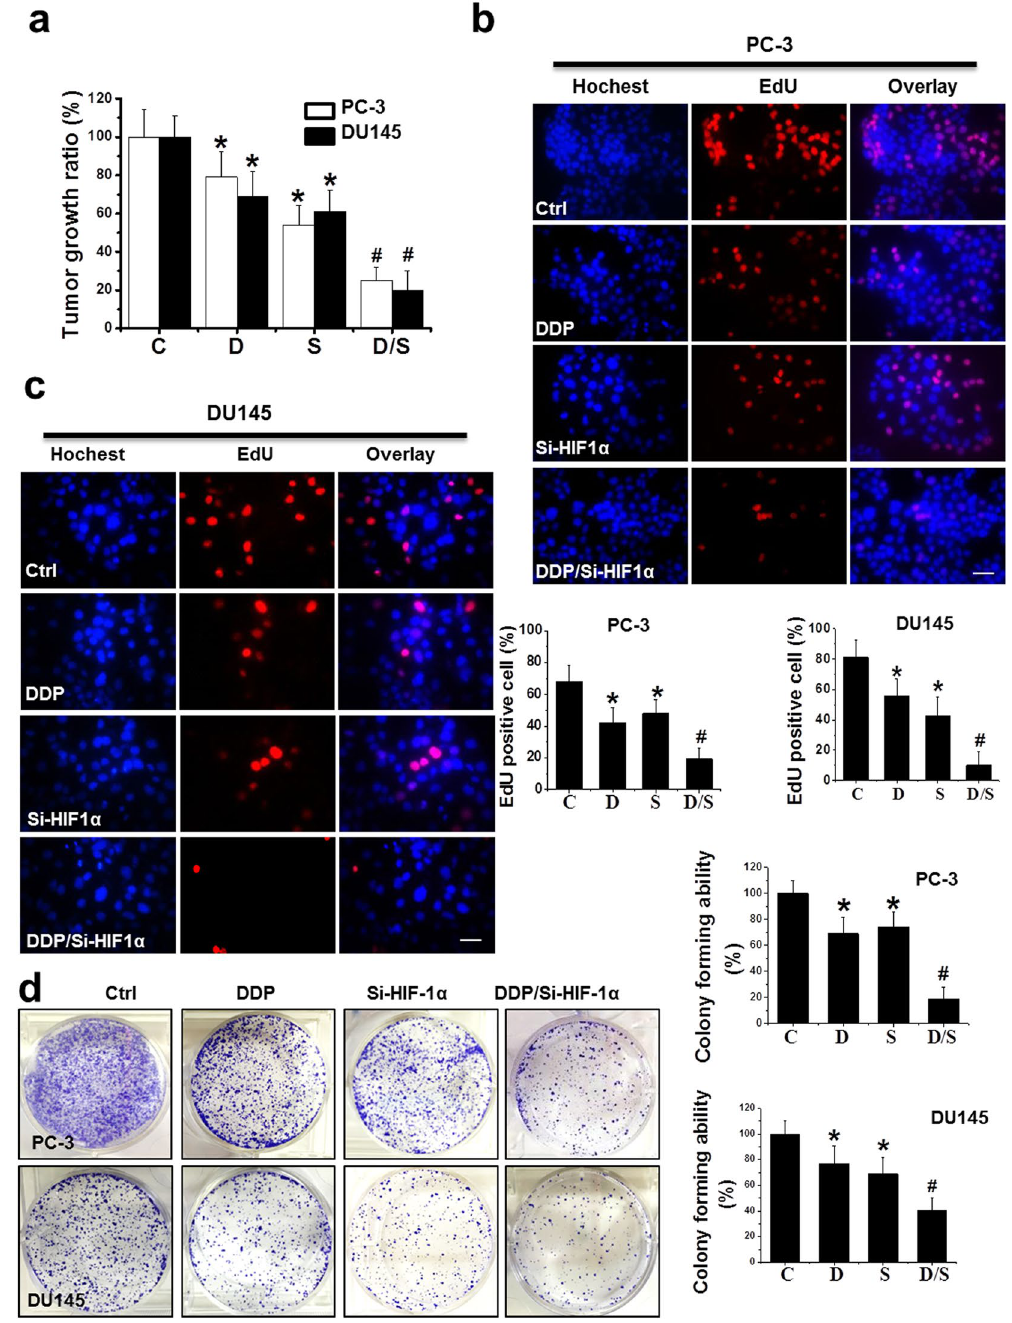
Figure 2. Inhibition of PCa cell growth in vitro by various treatments. ( a ) Cell viability was assessed using a MTT assay in PC-3 and DU145 cells after various treatments as indicated. ( b , c ) Cell proliferation was examined using an EdU assay in PC-3 ( b ) and DU145 ( c ) cells after various treatments as indicated (scale bars = 25 µ m). ( d ) Colonies of PC-3 and DU145 cells were stained with crystal violet 14 days after treatment and counted. Data were presented as mean ± SD of three independent experiments. * p < 0.05 versus control group; # p < 0.05 versus si-HIF-1 α or DDP